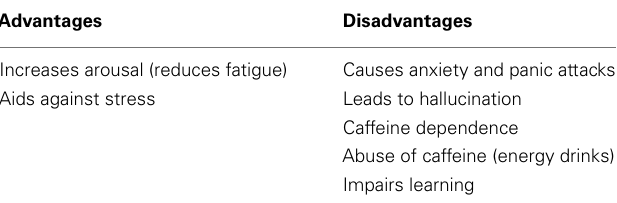
Table 3 | Summary of some effects of caffeine on